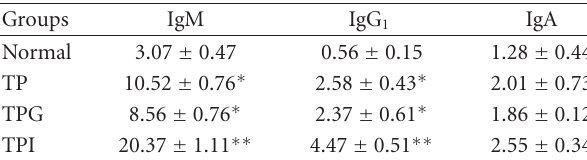
Table 2: Blood levels of IgM, IgG 1 ,and IgA (mean ± SD) (mg/dL).